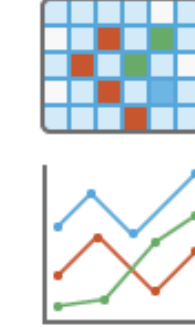
Figure 3. Schematic diagram of time series